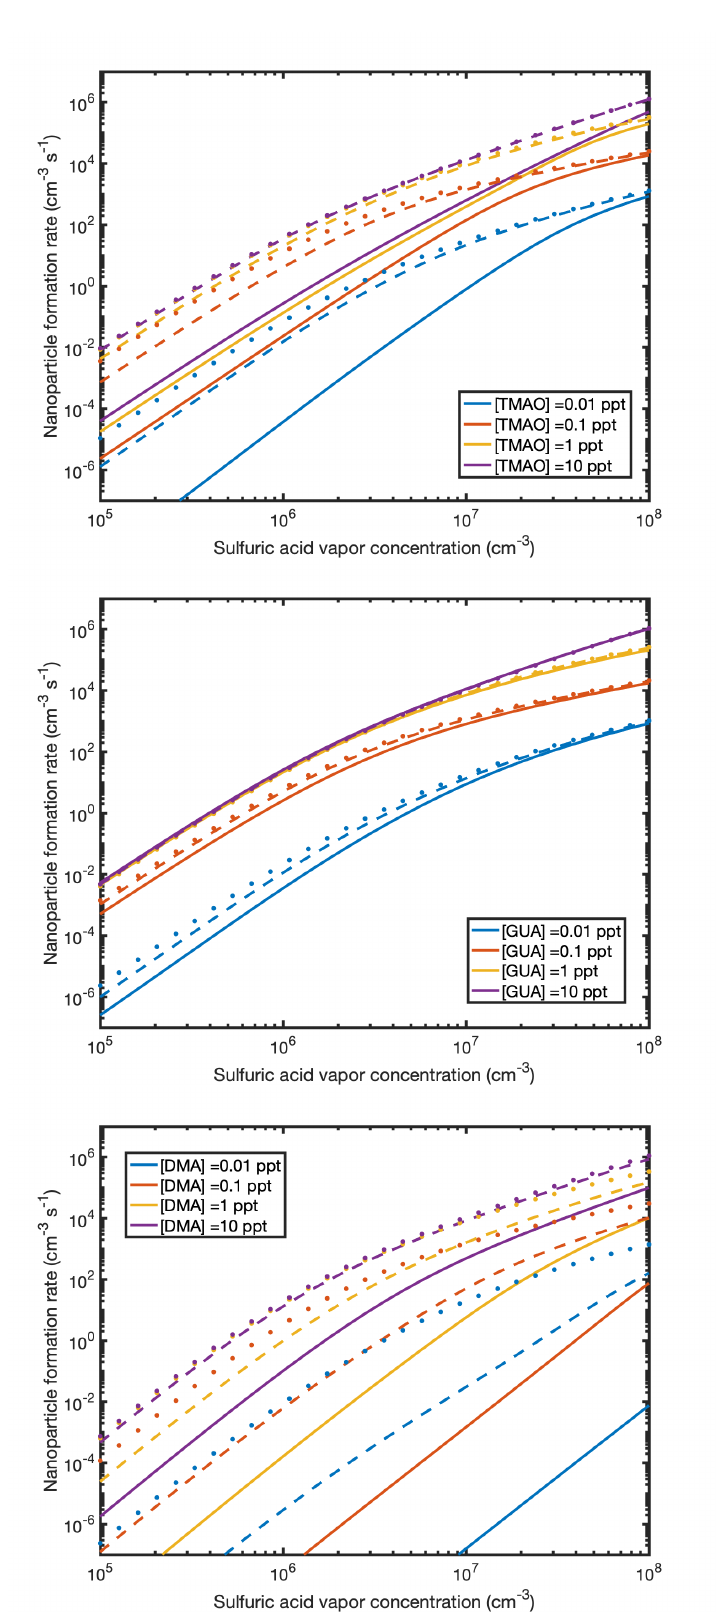
Figure 10. Nanoparticle formation rates as a function of sulfuric acid monomer concentration for TMAO ( top ), GUA ( middle ), and DMA ( bottom ). Solid lines represent T = 298.15 K, dashed lines are T = 273.15 K, and dots are T = 248 K. Note: 1 ppt = 2.46 × 10 7 cm − 3 V